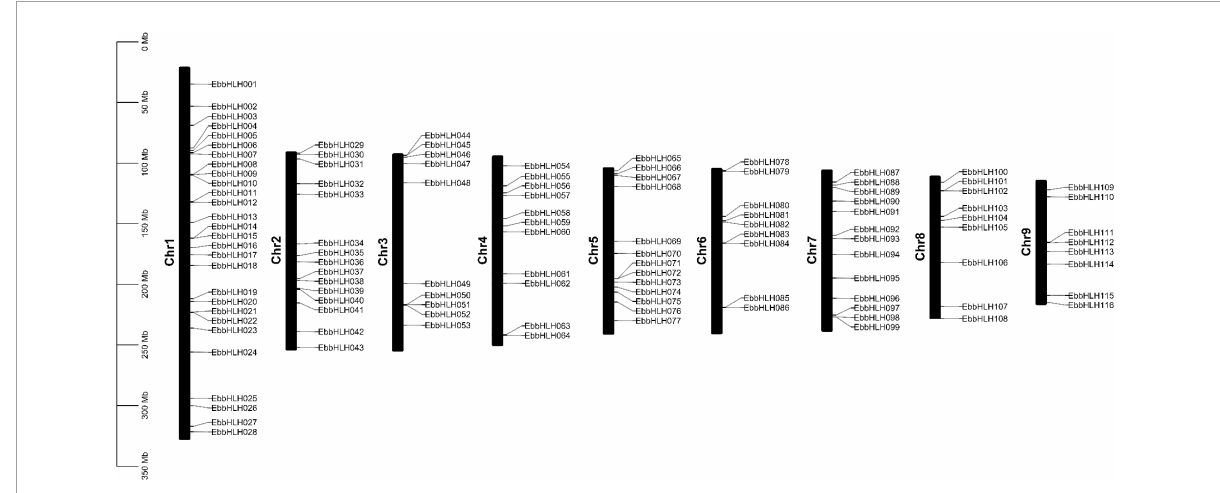
FIGURE1 Chromosome distribution of EbbHLHs gene. The chromosome number is shown in the middle of each chromosome.